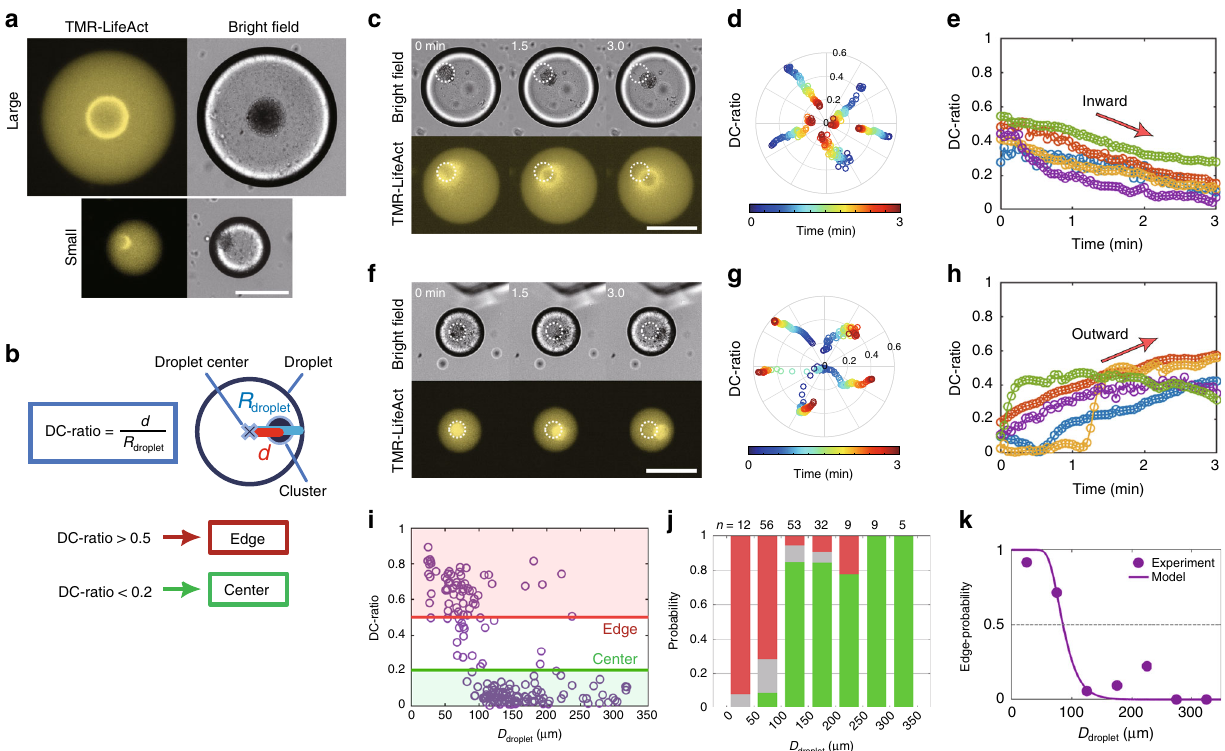
Fig. 2 Cluster position becomes off-centered as the droplet size decreases. a Typical examples of the droplet size dependence. Stable position of the cluster became off-centered in small droplets. Images were acquired 1 h after encapsulation. b Quanti fi cation of the cluster positioning symmetry. The polarity parameter DC-ratio is de fi ned as the ratio of d to R droplet , where d is the distance from the droplet center to the cluster centroid, and R droplet is the radius of the droplet. DC-ratio is classi fi ed into two distinct regimes: larger than 0.5 is the “ edge ” and smaller than 0.2 is in the “ center ” . c – h Typical examples of the c – e inwardly and f – h outwardly directed motion of clusters after their formation (Supplementary Movies 10 and 11). The time point at which clusters started to move (typically ~1 min after the cluster formation) is de fi ned as 0 min. The clusters either rested near their initial positions or moved away from the initial positions. Only the clusters that moved are shown. Different colors in e and h indicate different clusters. i – k Droplet size dependence of cluster position. i Raw data of DC-ratio showing two-state positioning. The stable position depends on the droplet diameter. We analyzed bright- fi eld images acquired more than 1 h after encapsulation. We performed two independent experiments ( n = 176 droplets). j Histogram of DC-ratio for each 50 μ m bins summarized from i . DC-ratio > 0.5, 0.5 ≥ DC-ratio ≥ 0.2, and 0.2 > DC-ratio are colored in red, gray, and green, respectively. k Edge- positioned probability calculated from j . Filled circles and the solid curve represent experimental values and model fi tting of Eq. (2), respectively. Experimental data were fi tted by Eq. (2) using L = 6.1 μ m and τ = 0.46 s. Transition diameter D c = 85 μ m at which edge-probability becomes 0.5 was estimated from the fi tting curve. Scale bars, 100 μ